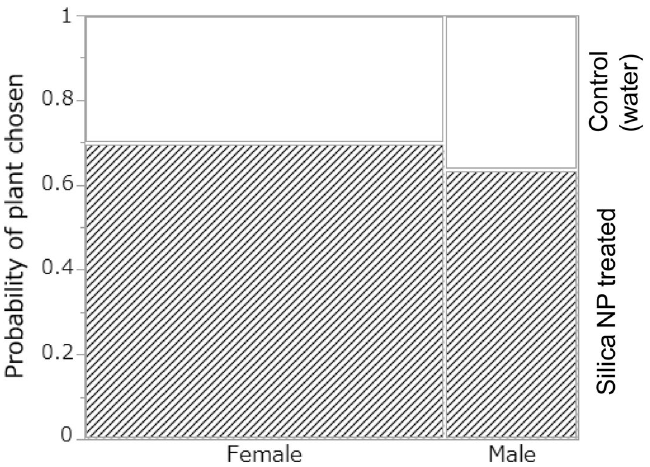
Figure 5. Probability of a plant being chosen by the rove beetle Paederus fuscipes . Shaded area: the probability of the beetle choosing an infested plant (soybean infested with the cotton leafworm Spodoptera litura larvae) treated with silica nanoparticles (NPs). White area: the probability of the beetle choosing an infested plant treated with